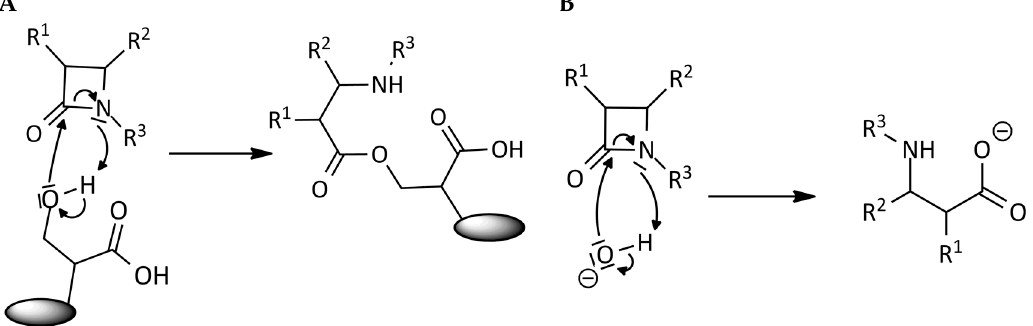
Figure 1. ( A ) Molecular mechanism of action of β‐ lactams towards acylation of a key serine residue within the active site of PBPs. ( B ) Hydrolytic reaction of the β‐ lactam ring induced by a hydroxide ion to yield antibiotically inactive penicillic acid, and downstream further polar degradation products.